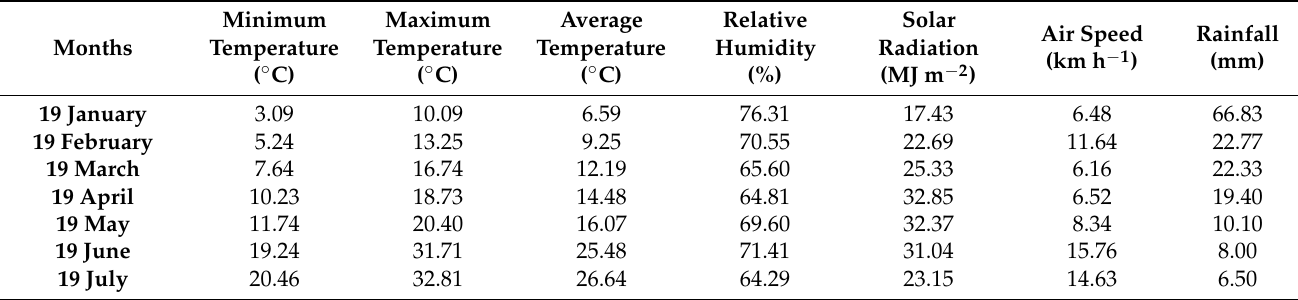
Table A2. Mean collected environmental parameters used for daily ETo estimation at Apulia